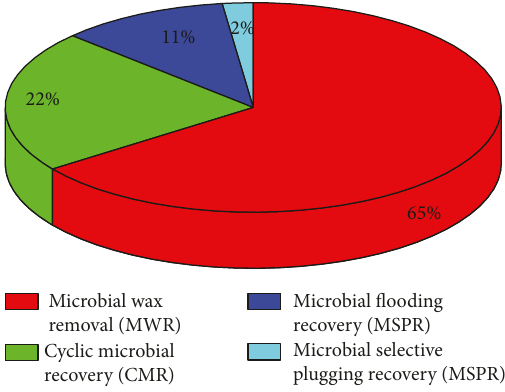
Figure 7: MEOR applications in China.